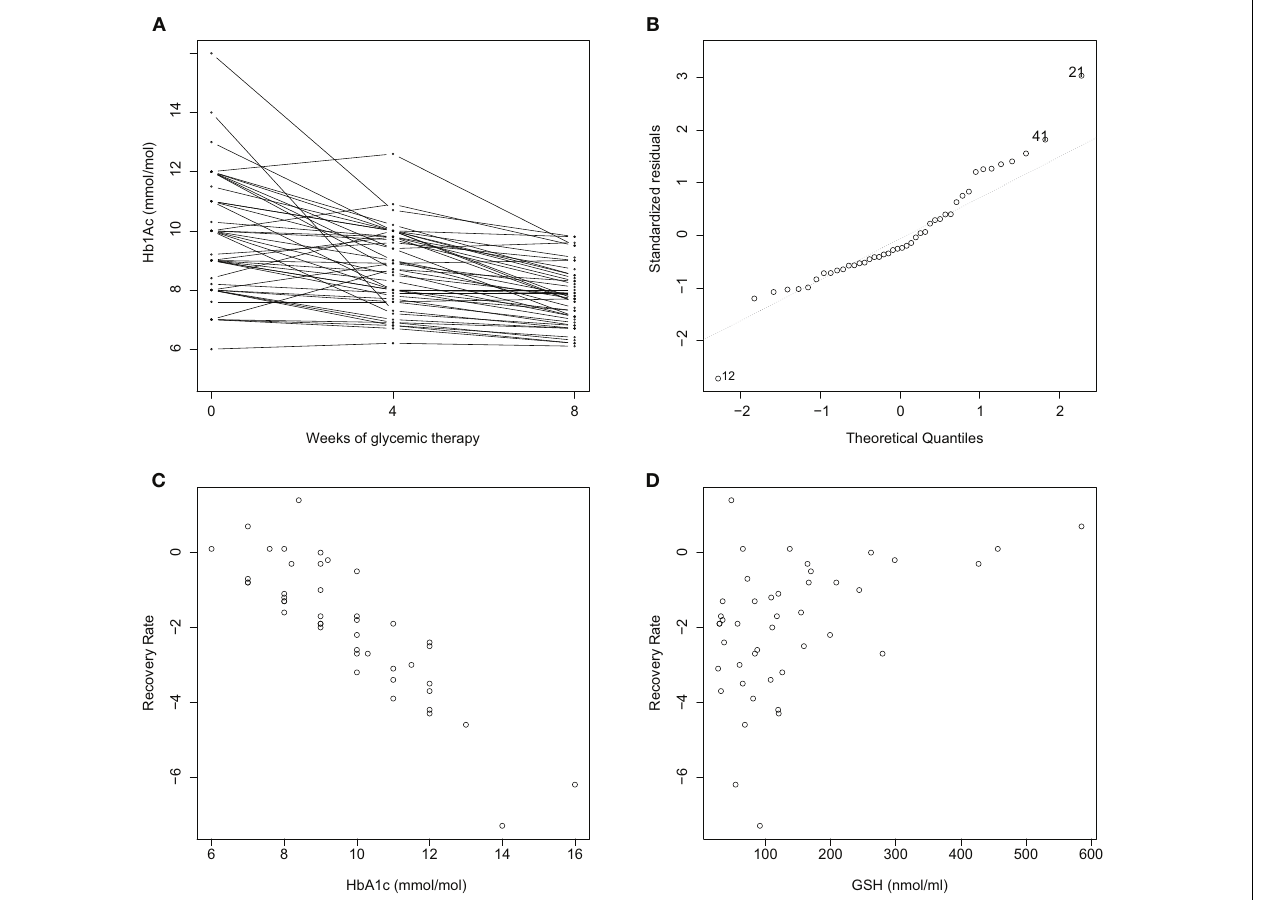
A1C – 0-week A1C). (B) A normal Q–Q plot reveals two outliers, Cases 12 and 21. RR varies with (C) 0-week A1C, and (D) 0-week GSH. A multiple linear regression analysis of RR with respect to 0-week A1C, GSH and age is described in the text. Data collection is described in Ref. (16); outliers were removed, and A1C and GSH were normalized as z -scores in the